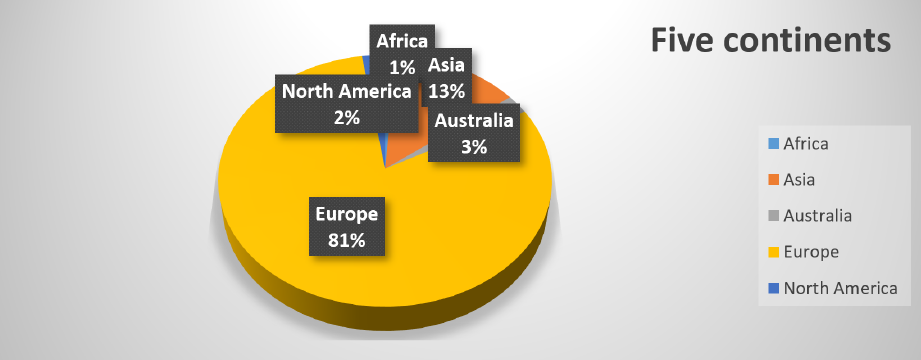
Figure 1. Five continents: Africa 1, Asia 11, Australia 2, Europe 66, North America